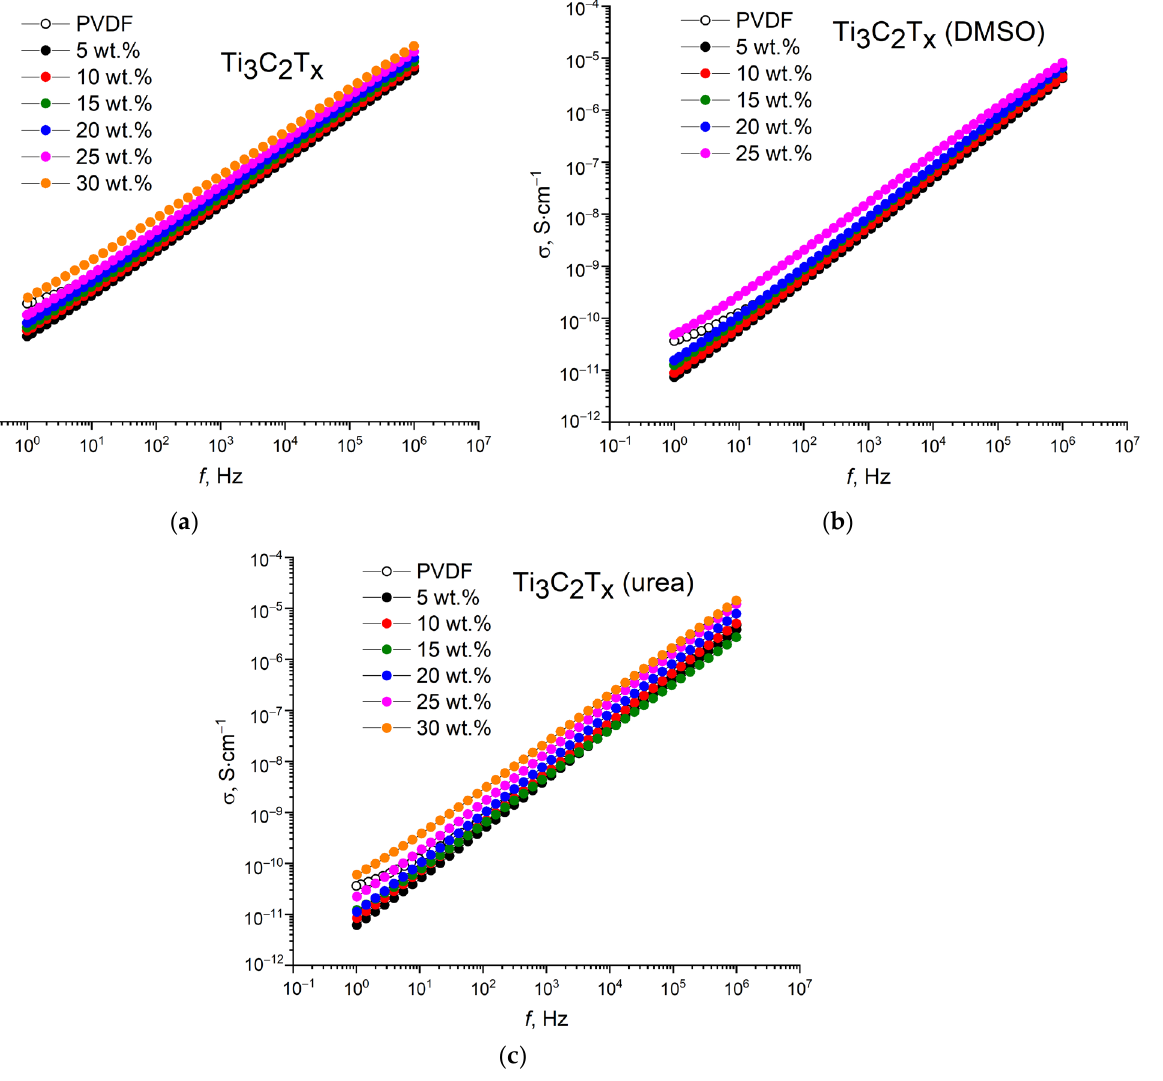
Figure 7. Frequency dependences of conductivity of ( a ) PVDF/Ti 3 C 2 T x , ( b ) PVDF/Ti 3 C 2 T x (DMSO), and ( c ) PVDF/Ti 3 C 2 T x (urea) nanocomposites.